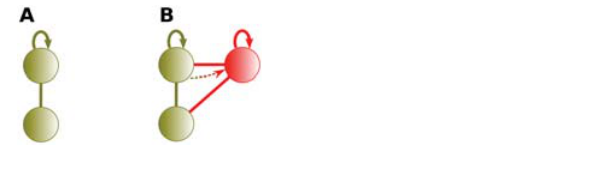
Figure 1. Duplication of self-interacting proteins. (A) An interaction between a protein and a self-interacting protein. (B) When the self-interacting protein duplicates, the duplicates interact.